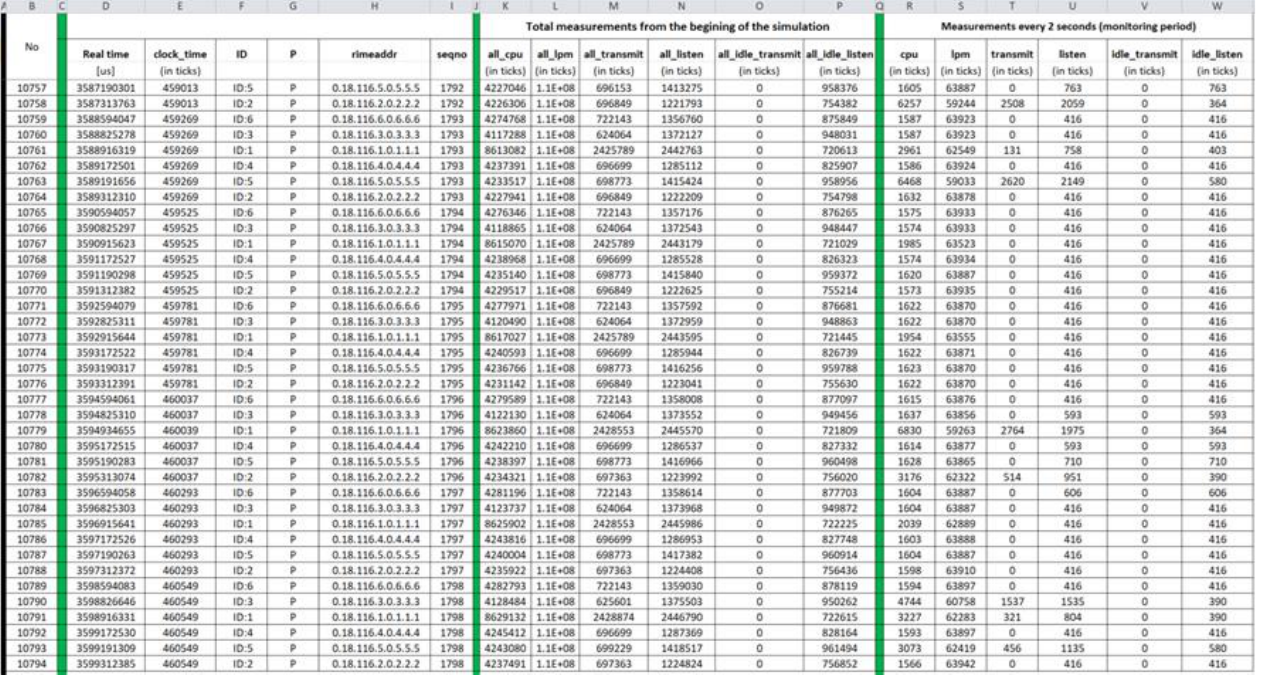
Figure 13. Benign “recv.csv”— 1 to 25 records.